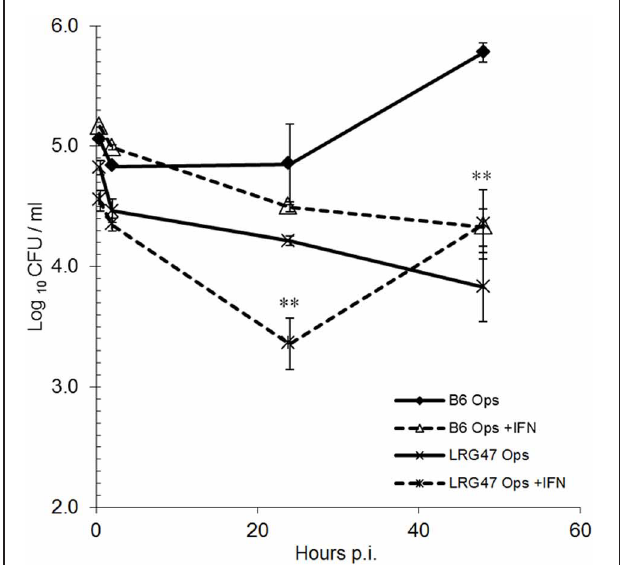
FIGURE 2 | Constitutive expression of LRG-47 aids in bacteria replication and survival. RAW264.7 murine macrophages stabley transfected with Flag-tagged LRG-47 (Raw264.7 LRG) were infected with virulent Brucella abortus . Colony forming units/ml were enumerated at 0.5, 1, 24, and 48h post infection and compared with the CFU/ml values for non-activated RAW264.7 cells (Raw264.7) and IFN- γ activated RAW264.7 cells (Raw264.7 IFN) both of which are not overexpressing the LRG-47 protein. (Student’s T- test p values ∗ < 0 . 05; ∗∗ < 0 . 01).